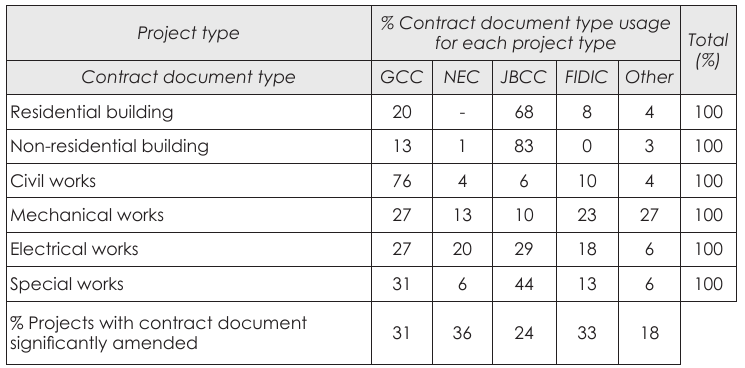
Type of contract used for different project types 2014 Project